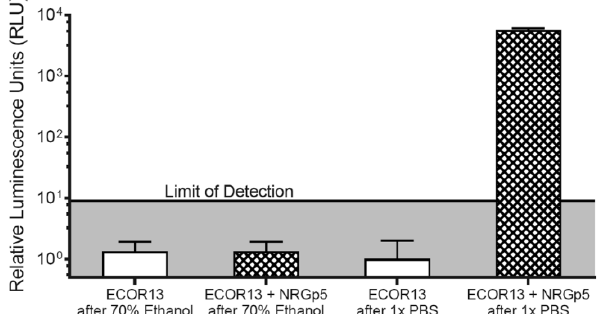
Figure 4. NRGp5 was added at a high multiplicity of infection (MOI) to varying concentrations of E. coli ECOR13. The luminescence of the lysate resulting from the infections was measured following the addition of substrate. The results suggest relative relationship (R 2 = 0.9941) between the concentration of E. coli and the generation of the luminescent signal over several orders of magnitude.